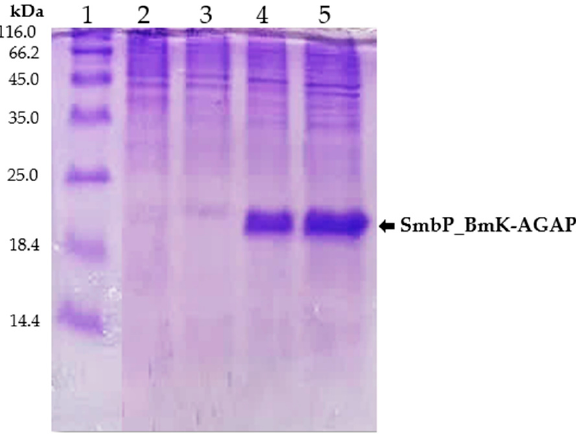
Figure 2. SDS-PAGE (15%) analysis of SmbP_BmK-AGAP small-scale expression. Lane 1: protein marker; Lane 2 and 3: lysates from untransformed and uninduced cells respectively; Lane 4 and 5: lysates from two different colonies of E. coli SHuffle cells expressing SmbP_BmK-AGAP (calculated molecular weight: 18.2 kDa).